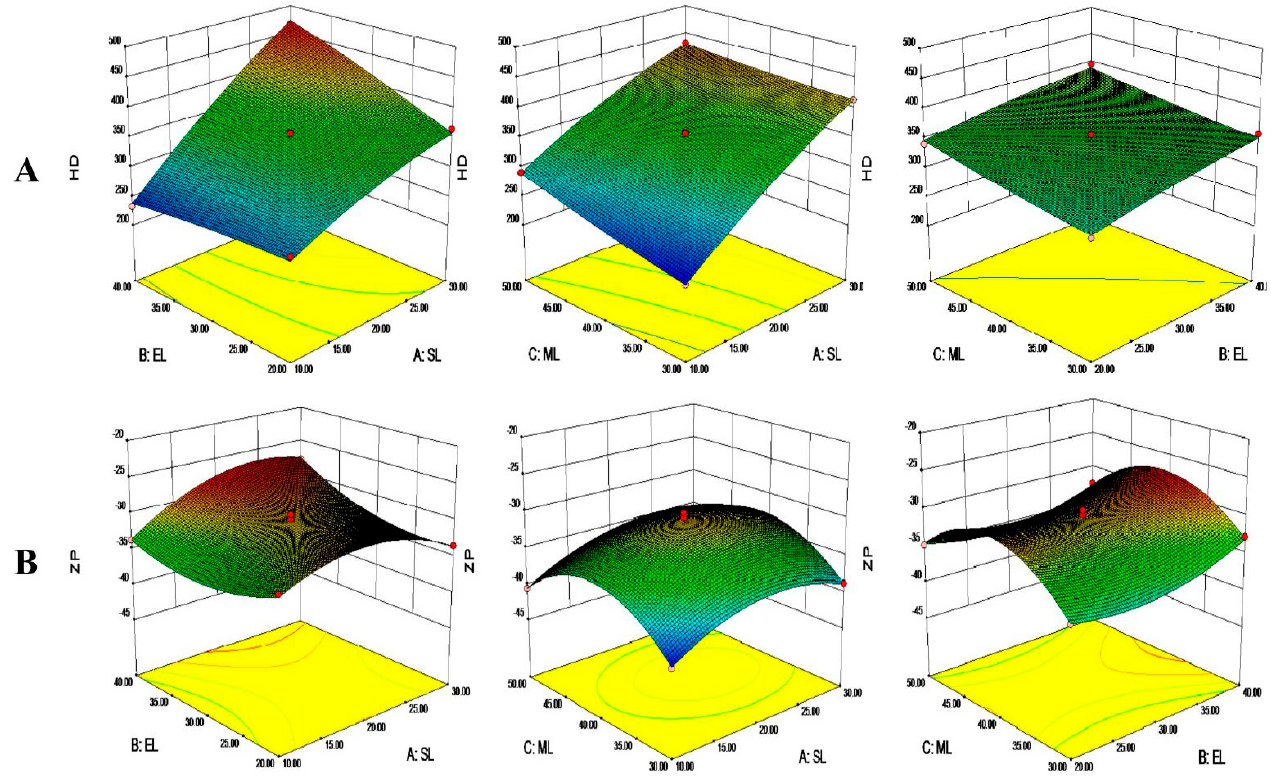
Figure 2. Three-dimensional response surface images of the solid lipid to lipid ratio (SL), emulsifier to lipid ratio (EL), and MAD to lipid ratio (ML) on ( A ) the hydrodynamic diameter (HD) and ( B ) zeta potential (ZP).